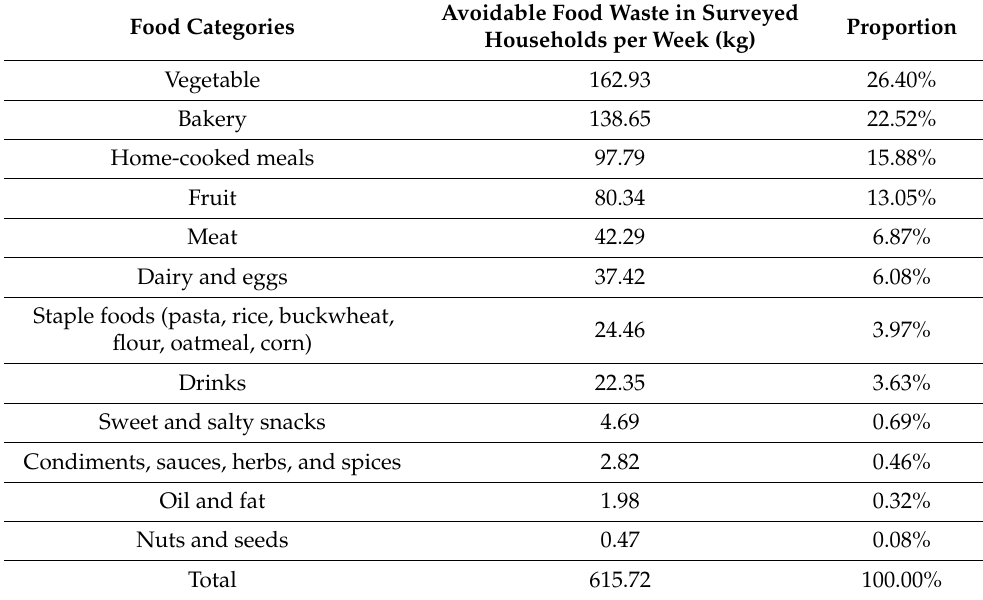
Table 3. Quantity of avoidable food waste by food categories based on a one-week measurement. Food